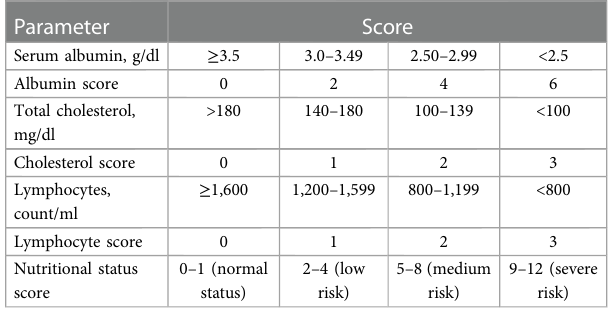
TABLE 1 Controlling nutritional status (CONUT)